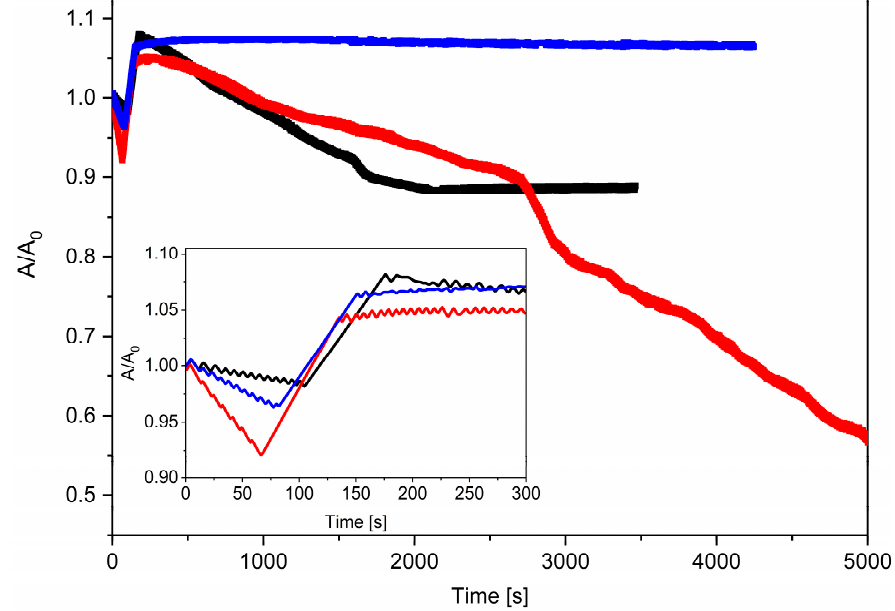
Figure 3. Relative area–time curves for DPPC + 2.5% MPs (20 µL) with different molar ratios of cholesterol (black line—DPPC + MPs; red line—DPPC:Chol (1:1) + MPs; blue line—DPPC:Chol (9:1) + MPs).